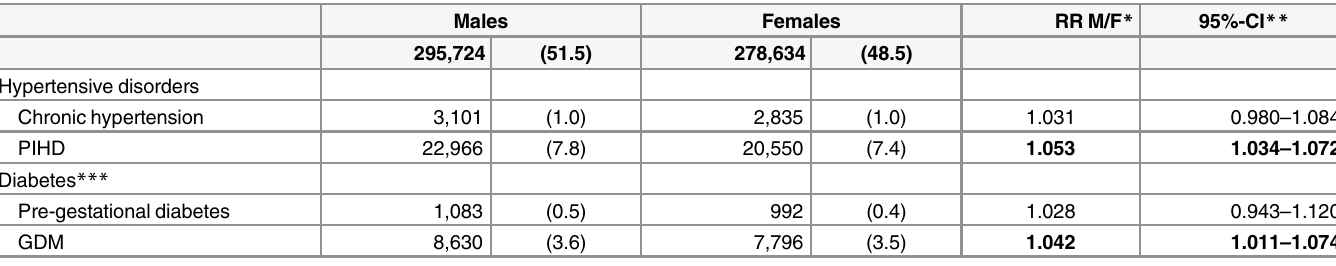
Table 5. Diabetes and hypertensive disorders according to fetal